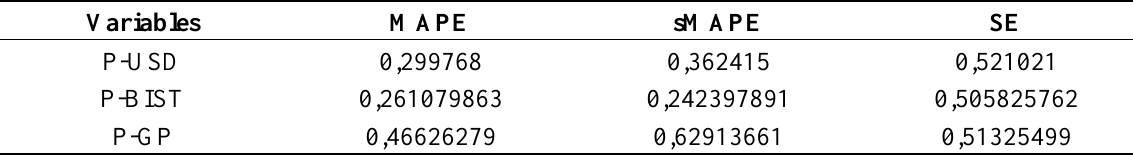
Table 4. Some symmetry measures during the financial crisis with the results of the second ANN output